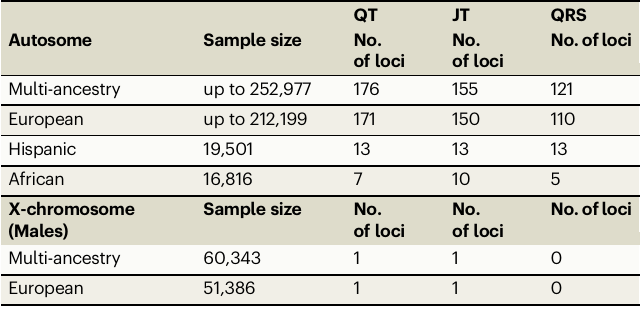
Numberof loci identi fi ed foreach ECG trait split intoautosome meta-analyses and X-chromosome sex-strati fi edanalyses. Sample size maximum samplesize inthe meta-analysis, No. number.